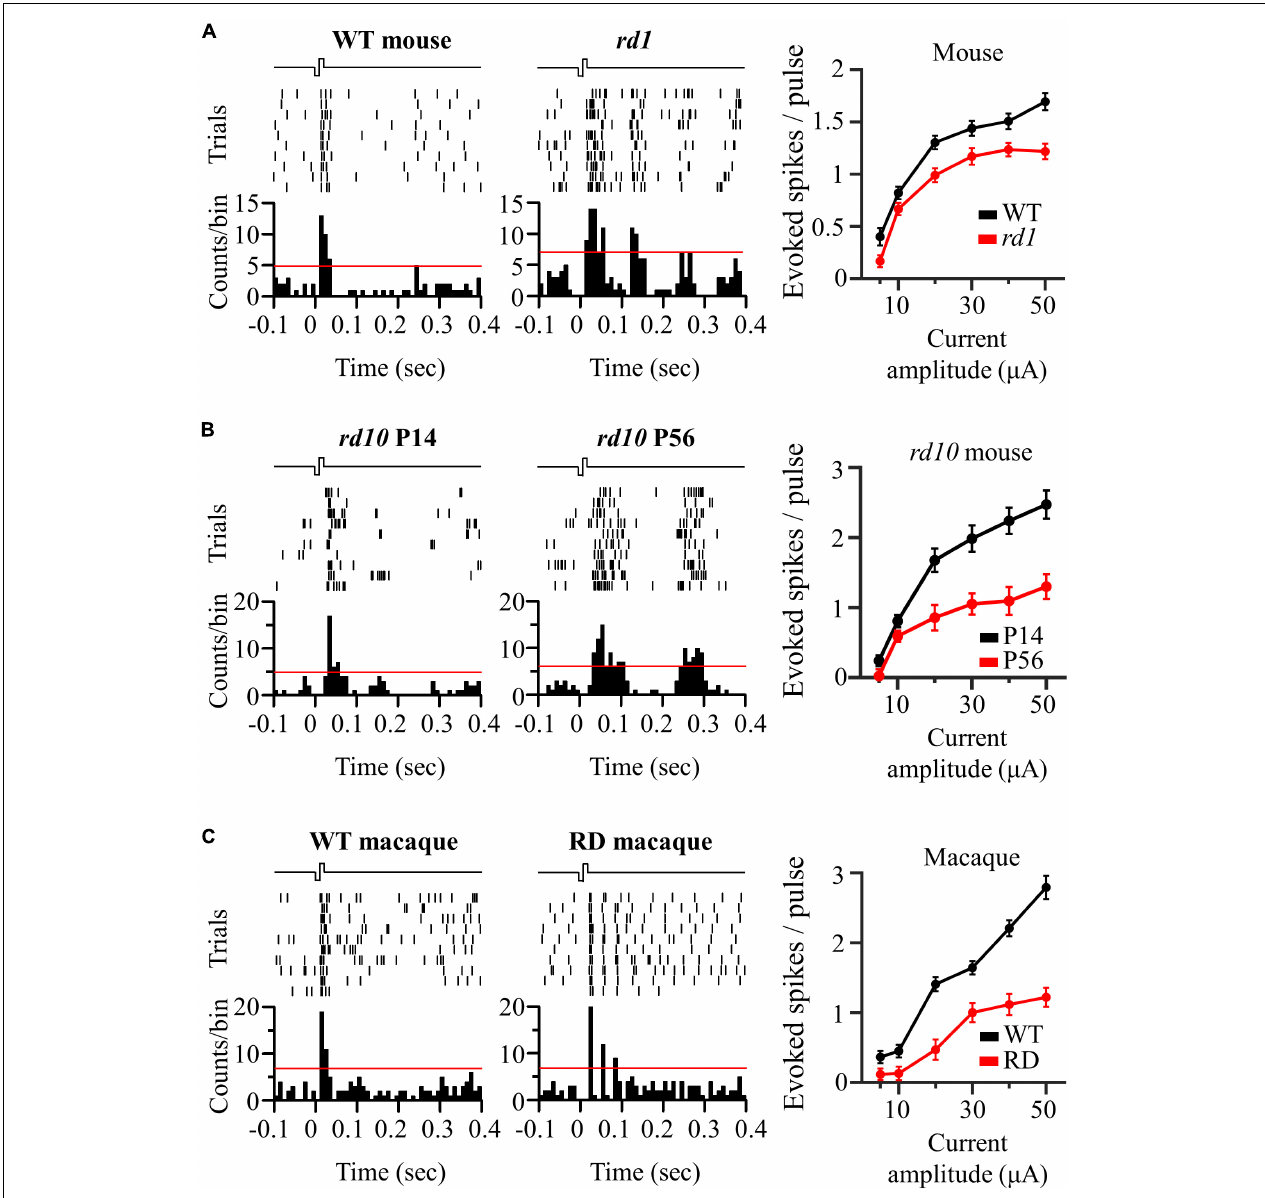
FIGURE 3 | Oscillatory rhythm leads to multiple peaks of electrically evoked RGC responses in degenerate retina. (A) The responses of wild-type and rd1 RGCs that are located 200 µ m away from the stimulation electrode upon electrical stimulation with a pulse amplitude of 50 µ A and a pulse duration of 500 µ s. Top left panel: raster plot of wild-type RGC (10 trials). Lower left panel: post-stimulus time histogram (PSTH) accumulated over 10 trials. The time bin for PSTH is chosen to be 10 ms. The red line indicates the significance level, expressed as the 99% confidence limit for PSTH. Top middle panel: raster plot of rd1 RGC. Lower middle panel: PSTH on rd1 . Right panel: RGC response curve with increasing pulse amplitude. (B) The same representative figures with rd10 P14 and rd10 P56. (C) The same representative figures with wild-type and RD macaque.